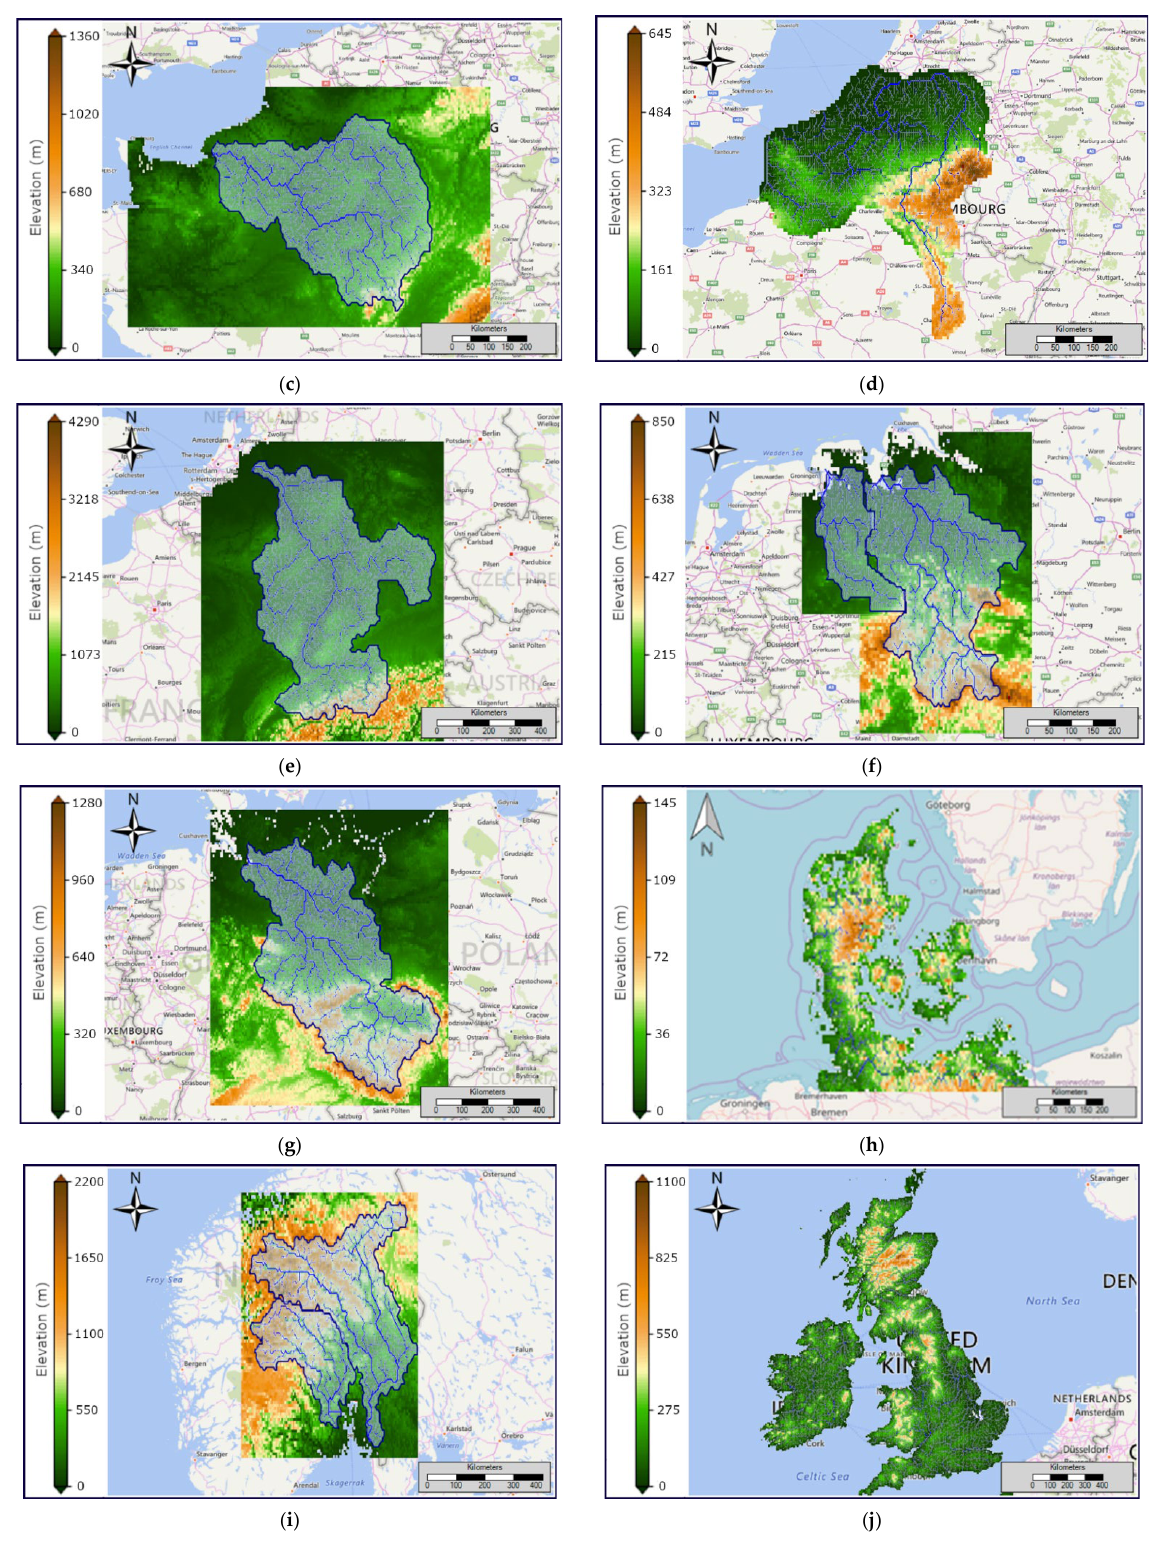
Figure 1. Topography and drainage network of the LAMBDA project watershed domains. The LAMBDA watershed domains are: ( a ) Western Iberian Peninsula domain; ( b ) Western France domain; ( c ) Seine River domain; ( d ) Somme, Scheldt, and Meuse rivers domain; ( e ) Rhine River domain; ( f ) Northwest Germany domain; ( g ) Elbe River domain; ( h ) Denmark domain; ( i ) Southern Norway domain; ( j ) United Kingdom and Ireland